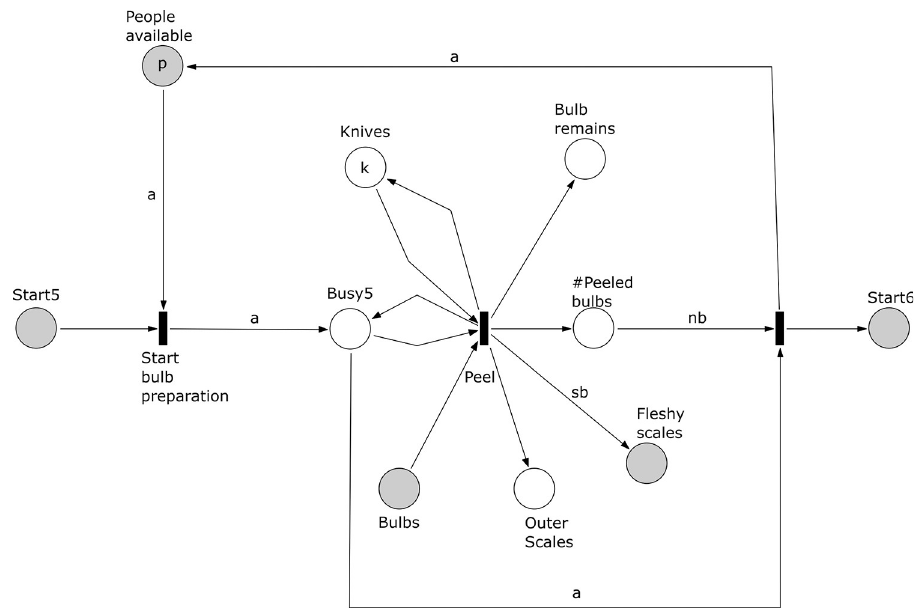
Fig 7. Subprocess 5 Prepare Bulbs of the A . coranica model.